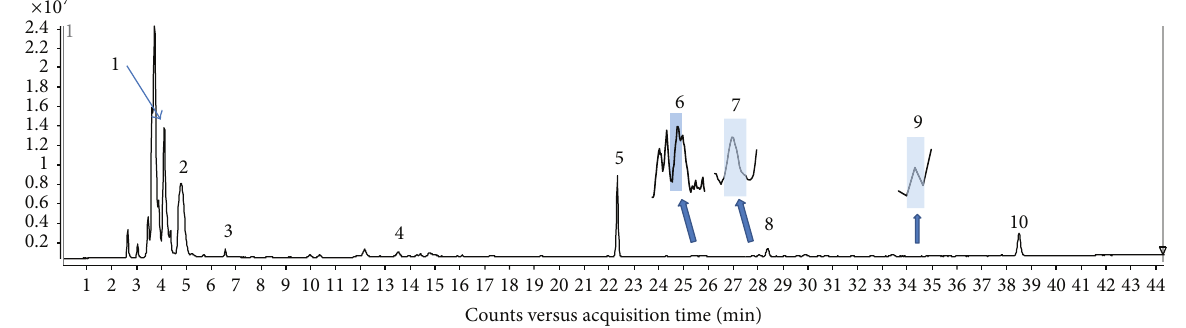
Figure 1: The typical total ion chromatogram (TIC) of C. mas fruit puree. Ionization source performed on Agilent Jet Stream TOF-MS with electrospray ionization (ESI) negative mode. (1) x -axis represents retention time and y -axis is intensity of 𝑚/𝑧 peaks. (2) Peaks 1–10 were identified as tartaric acid ( 1 ), malic acid ( 2 ), citric acid ( 3 ), gallic acid ( 4 ), chlorogenic acid ( 6 ), rutin ( 9 ), and four iridoids, loganic acid ( 5 ), loganin ( 7 ), sweroside ( 8 ), and cornuside ( 10 ). (3) Peaks 6, 7, and 9 were enlarged by zooming in.